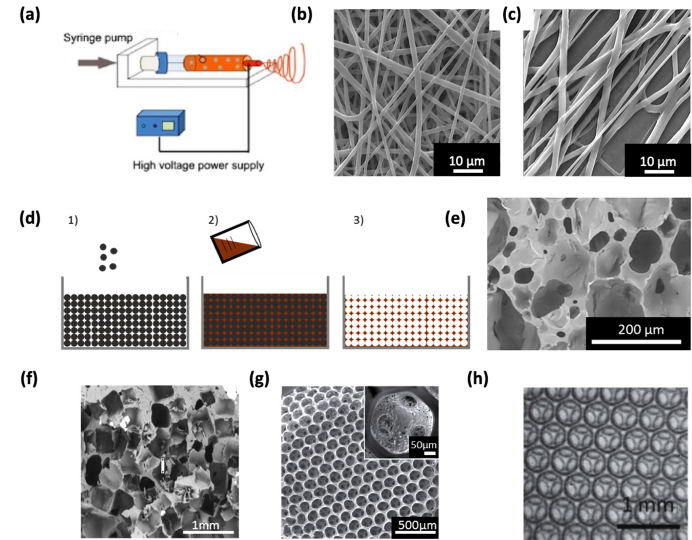
Figure 1. Illustration of the electrospinning process ( a ). Taken with permission from Li et al. [55] SEM images showing the fiber assembly either randomized ( b ) or aligned ( c ), adapted with permission from Ndreu et al. [11]. ( d ) Illustration of particle leaching process with the template formation (1) followed by matrix pouring (2) and particle dissolution (3) taken from Lutzweiler [56], SEM images of scaffolds generated by chemical foaming ( e ) taken with permission from Ng et al. [57], particle leaching using salt ( f ) taken with permission from Janik et al. [58], sphere templating ( g ) taken with permission from Choi et al. [59], and microfluidics ( h ) reused with permission from Testouri et al. [48].